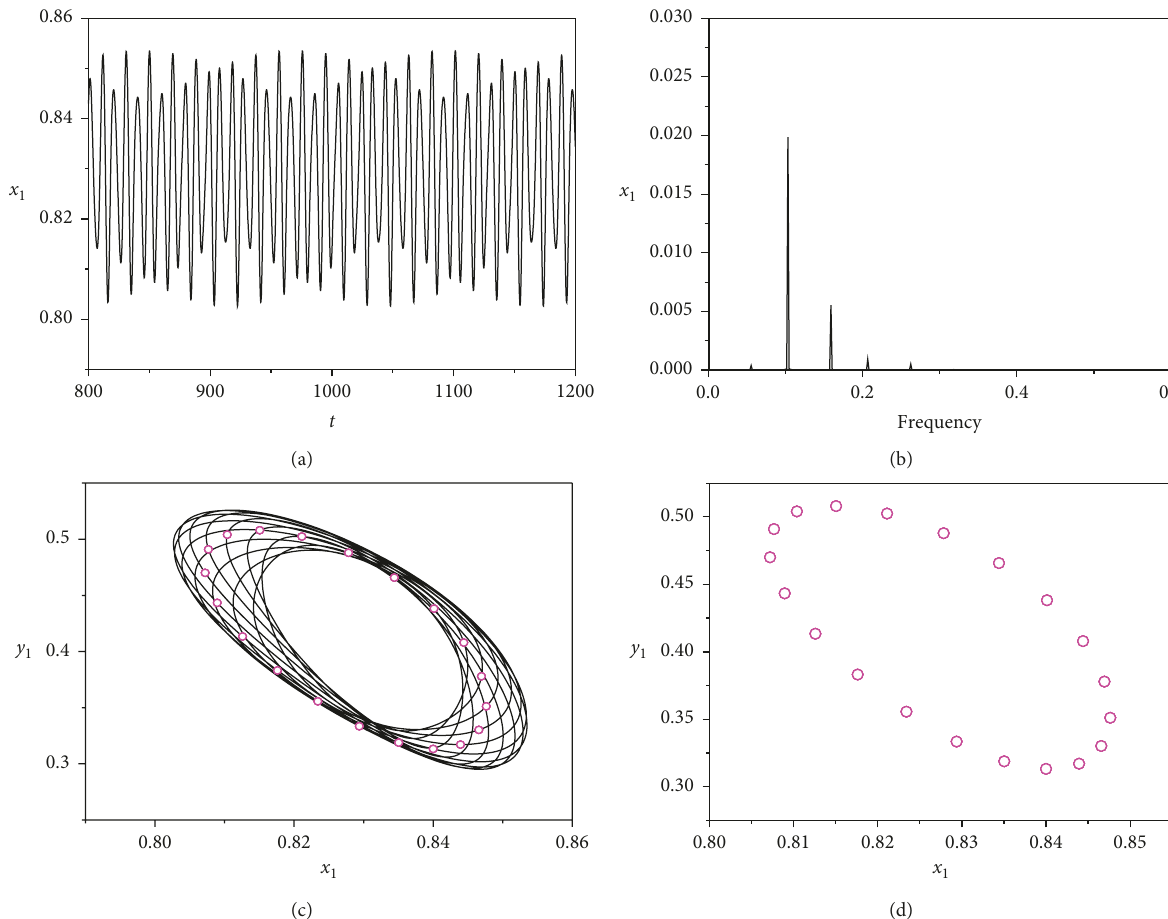
0.5880.5890.5900.5910.5920.5930.5940.5950.5960.597